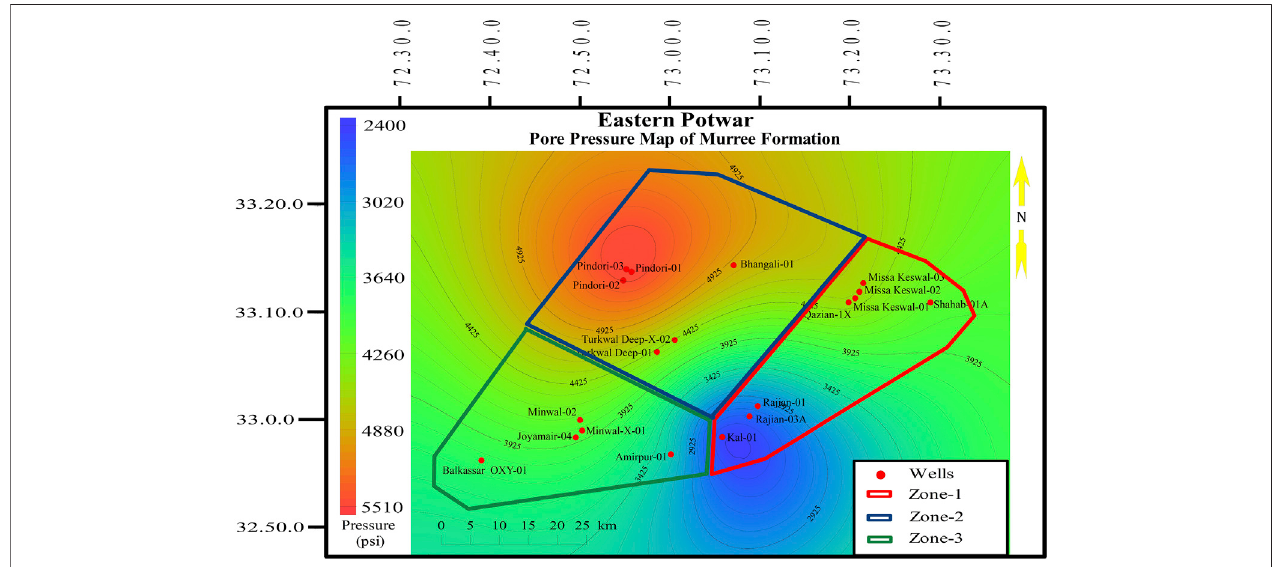
FIGURE12| Isomaplayerofporepressurepredictedin19wellsofeasternPotwar.PressurevariationsinMurreeFormationshowshighestporepressuresinzone- 2, ranging between 5000 and 5500 psi values in Pindori fi eld (red color fi ll). Rajian fi eld of zone-1 (blue color fi ll), experiences the lowest pressure conditions, which are less than 3000 psi values. Murree Formation in Qazian and Missa Keswal fi elds (northeastern part of zone-1) exhibits high pressures at a shallower depth. Minwal, Amirpur, and Balkassar oil fi elds of zone-3 follow the normal compaction trend in most of the drilled interval.